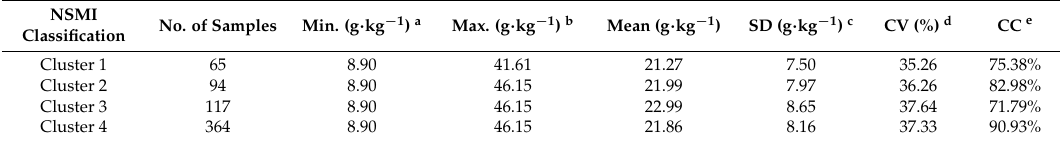
Table 2. Statistical characteristics of SOM contents using NSMI classification method in the calibration dataset.